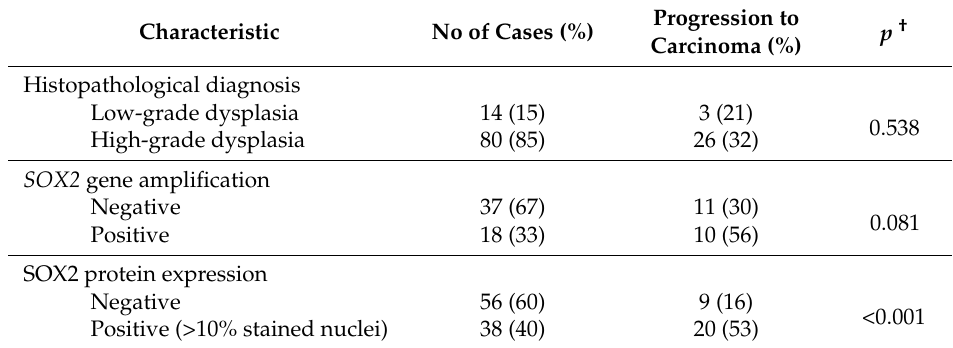
Table 1. Evolution of the premalignant lesions in relation to histopathological diagnosis, SOX2 gene amplification, and protein expression.